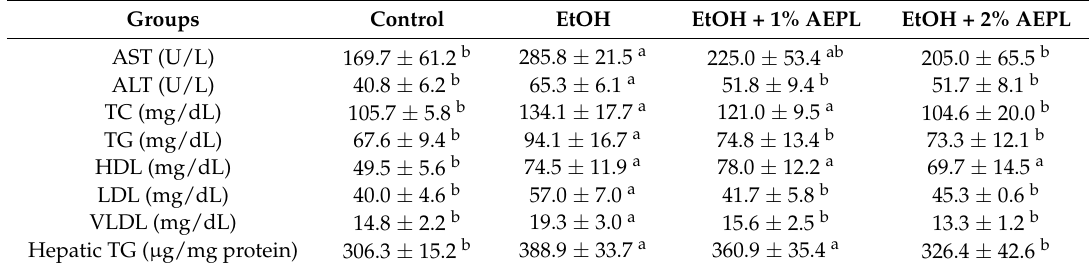
Table 3. Effects of different dose of AEPL on serum biochemical parameters and hepatic TG level in alcohol-induced liver injury in